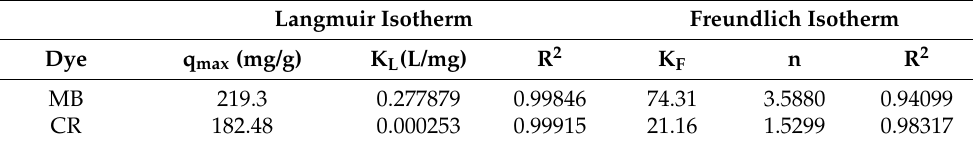
Table 2. Outcomes of Langmuir isotherm and Freundlich isotherm